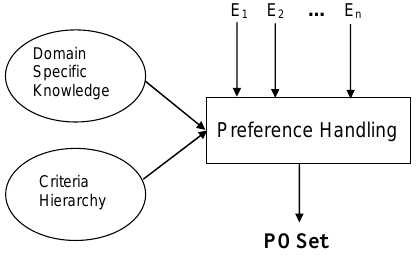
Fig. 3. Preference POSet